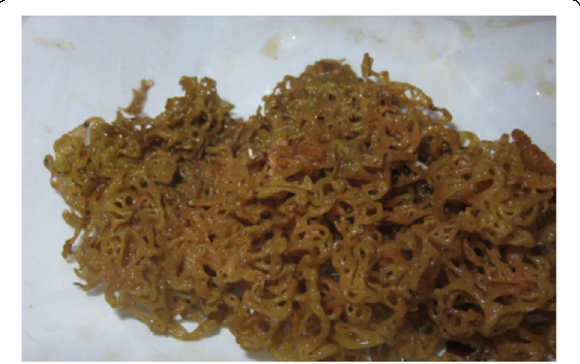
Fig. 1 Hydroclathrus clathratus (C. Agardh)